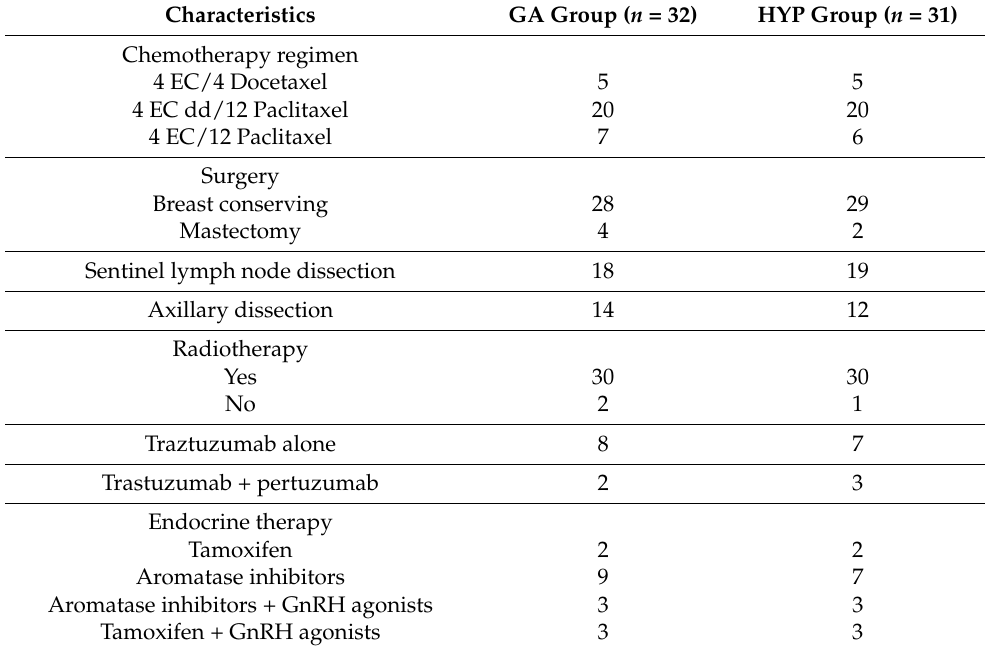
Table 2. Treatment